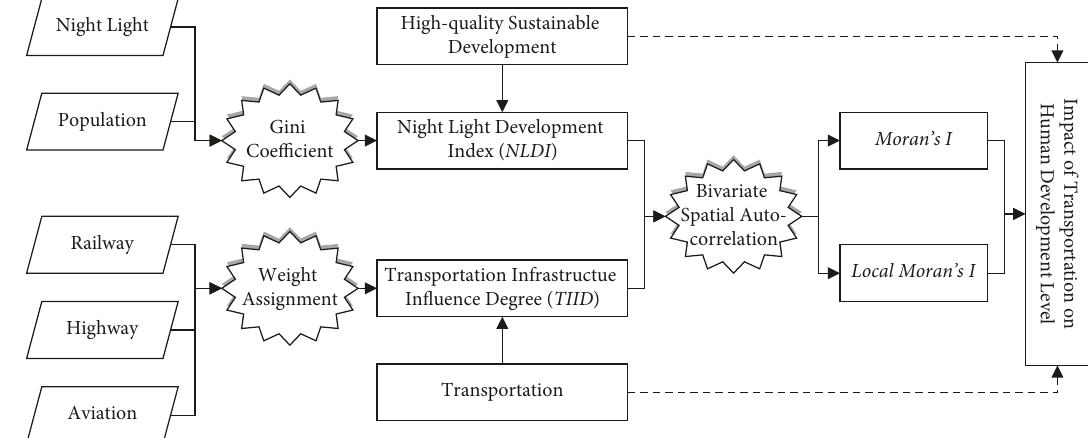
Figure 1: Research